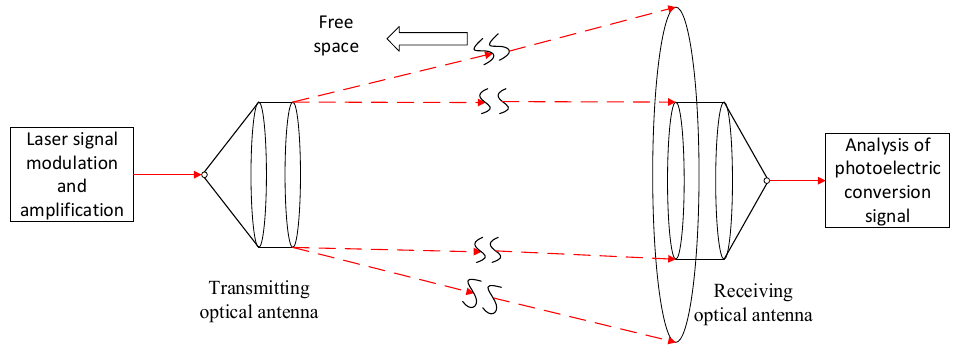
Figure 7. Simple block diagram of FSO communication .